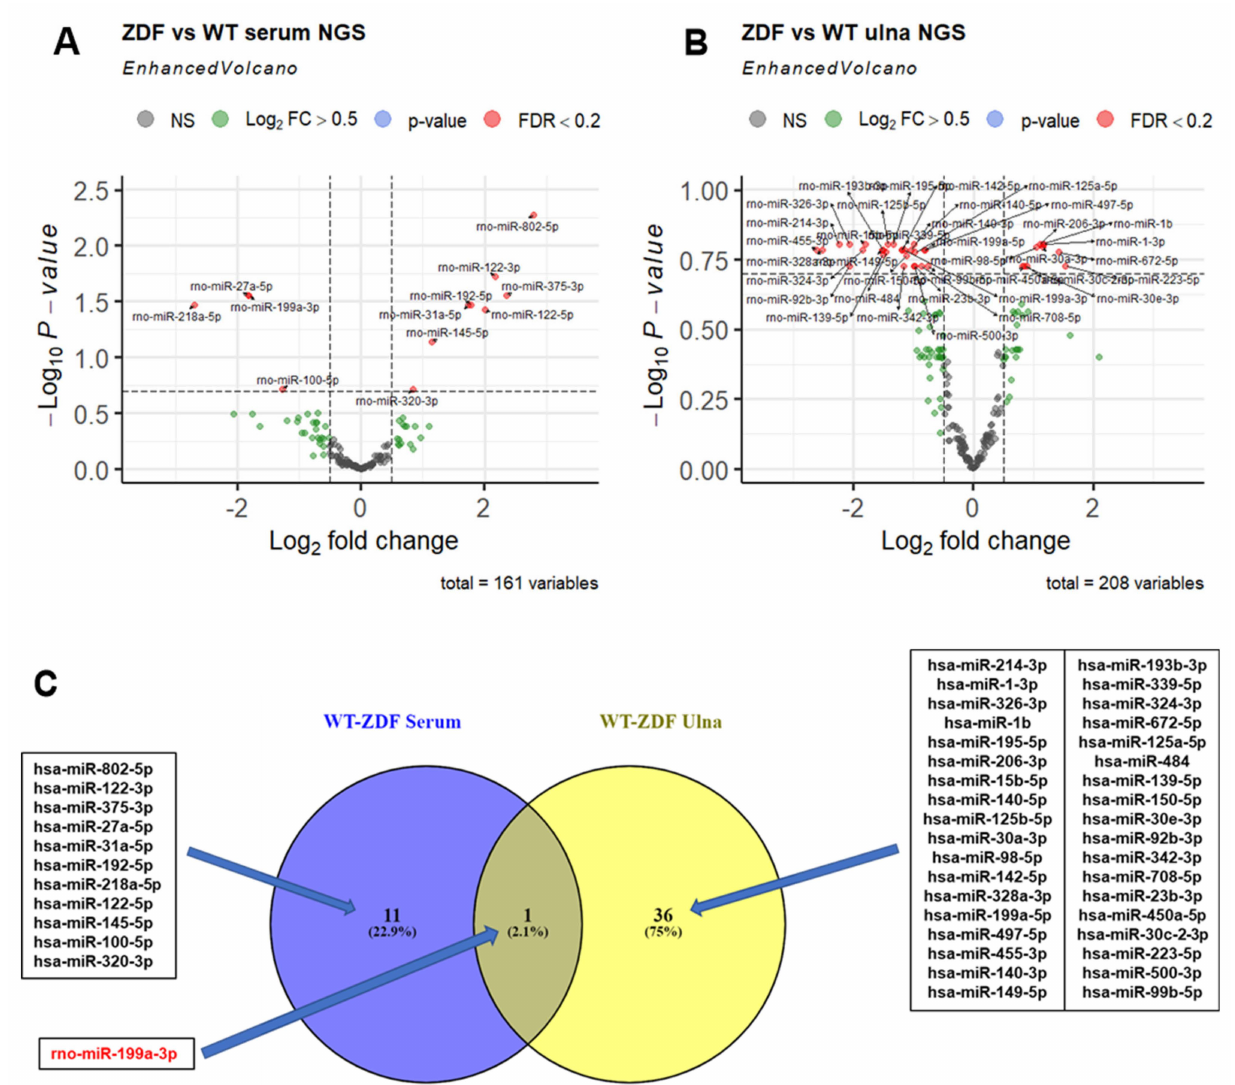
Figure 2. NGS-based discovery of miRNA changes in serum and ulna bone tissue of ZDF rats compared to WT rats under placebo treatment. ( A , B ) Volcano plots depict the log2-transformed fold change and log10-transformed adjusted p -values for the contrast (WT placebo, n = 5; ZDF placebo, n = 5) in both serum and ulna bone compartments. miRNA effects with Benjamini–Hochberg-adjusted p -values < 0.2 (FDR < 20%) are highlighted as separate group in red. ( C ) Comparison of miRNAs dysregulated in serum and in ulna bone (FDR threshold of 0.2). VENN diagram with the overlapping miRNA between the two compared lists corresponding to the miRNAs dysregulated in the ZDF model in serum (left circle) and ulna bone tissue (right circle). miR-199a-3p that is dysregulated in the ZDF model in both compartments is highlighted in